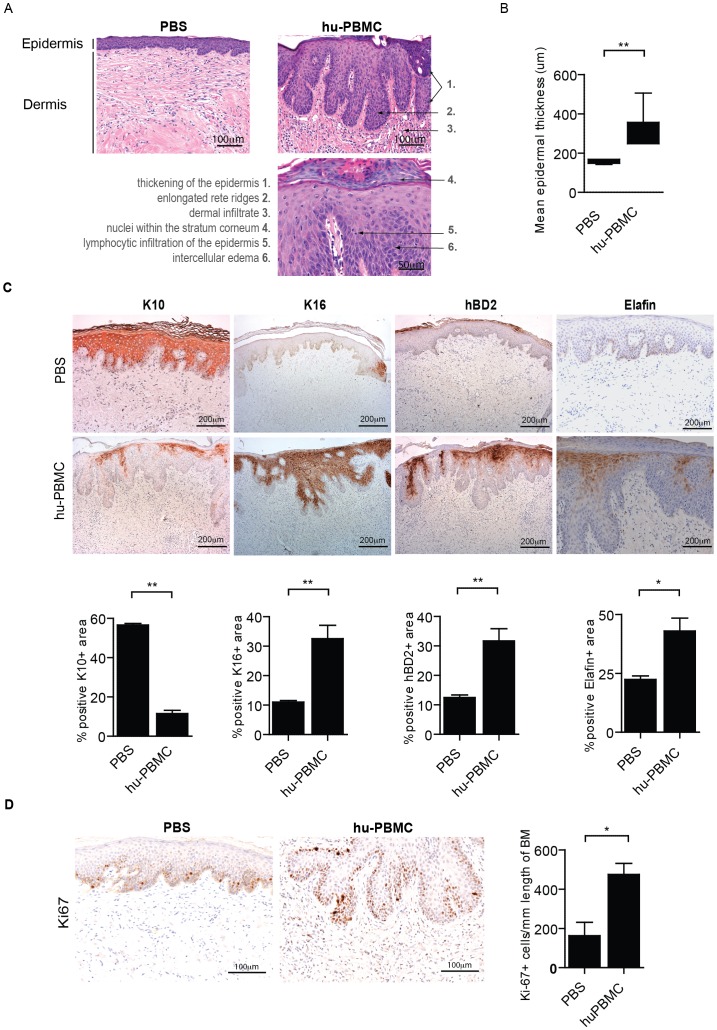
Acanthosis and aberrant epidermal marker expression of hBD2, Elafin, K10 and K16 in the inflamed human skin of the huPBL-SCID-hu Skin allograft model.
A. Histology (H&E staining) of human skin grafts from SCID beige mice 21 days after infusion (i.p.) of huPBMC. Representative photographs are shown after PBS (left photograph) and huPBMC infusion (right photograph). Photograph shows increased epidermal thickness (acanthosis) and elongated fingerlike epidermal projections into the dermis (rete ridges) and large lymphocyte infiltration after huPBMC infusion. Abnormal presence of nuclei in the stratum corneum (parakeratosis) and infiltration of lymphocytes in the epidermis (exocytosis) (bottom-right photograph). 20×, 20×, 40× magnifications respectively. B. Quantitative microscopic histological analysis of the epidermal thickness (µm) of human skin grafts following infusion of PBS and huPBMC. Mean±SEM are shown for n = 3 and 6 upon PBS and huPBMC infusion resp. C. Immunohistochemistry of K10, K16, hBD2 and Elafin (brown) in human skin grafts from SCID beige mice 21 days after infusion (i.p.) of PBS (top panels) or huPBMC (lower panels). Photograpsh show representative examples, summarized data are given in the figures. Mean±SEM percentages of the area positive for the indicated markers is shown for n = 3 and 5–8 upon PBS and huPBMC infusion resp. 10× magnification. D. Ki-67 expression (brown) in the stratum basale of the epidermis. The insert shows a higher magnification. A representative example of n = 12 is shown. 20× magnification. Graphs show summarized data of Ki67+ cells/mm length of basement membrane after PBS or huPBMC infusion in human skin biopsies (mean±SEM, of n = 4 and 6, resp.).